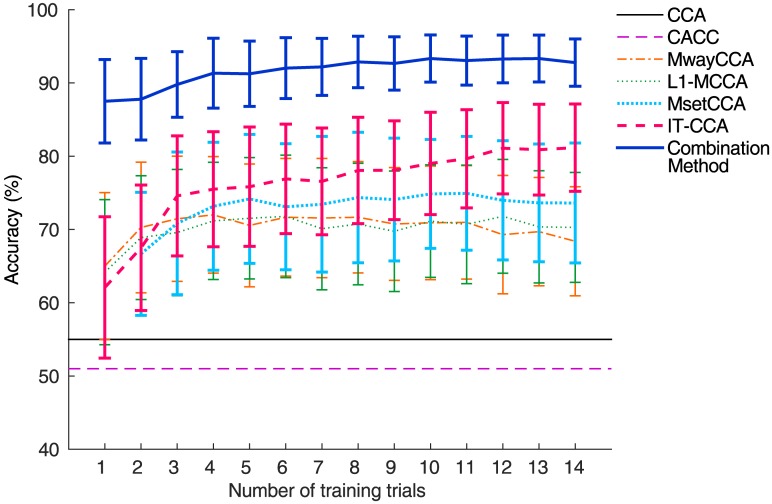
Averaged classification accuracy across subjects with different numbers of training trials for each method.Error bars indicate standard errors.